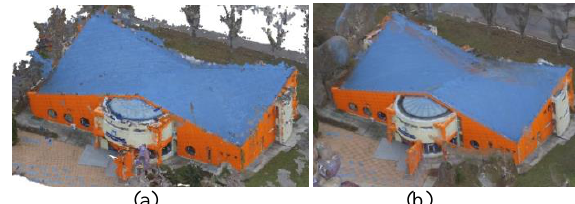
Figure 8. The „Dean’s office” building model, created in the Drone2Map software based on UAS images point cloud (a), mesh surface (b)